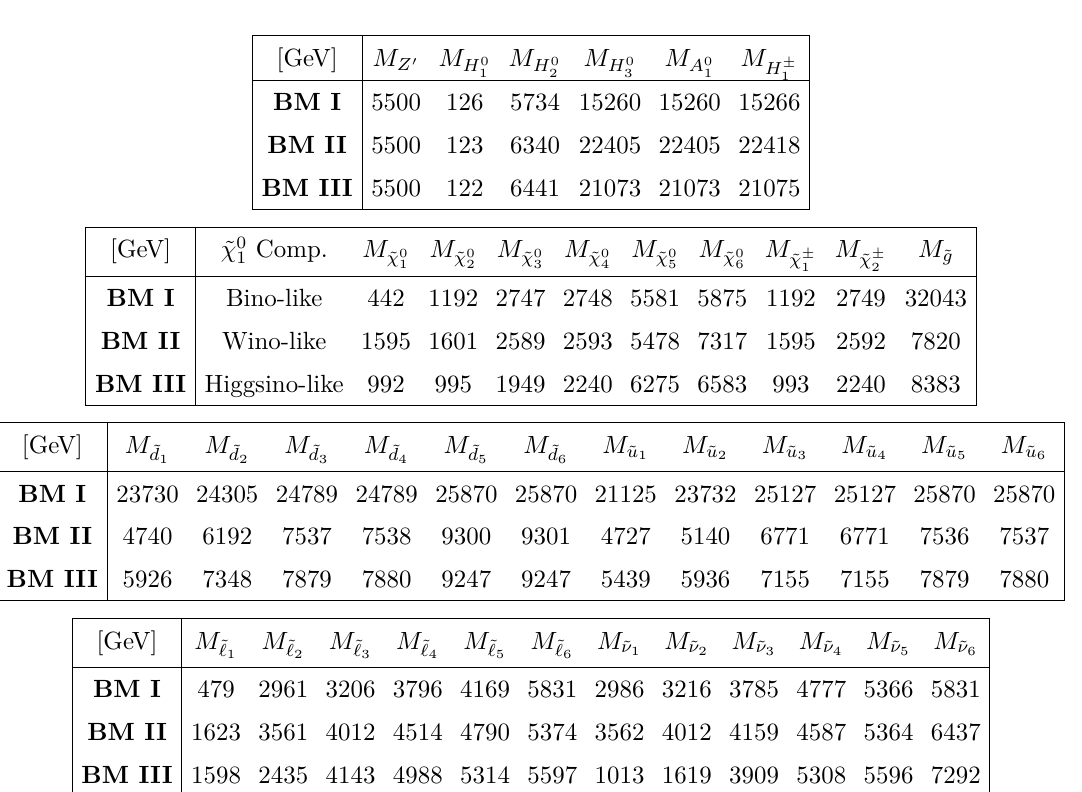
Table 6 . Particle spectrum of BM I , BM II and BM III : bosons (top), fermions (middle), squarks and sleptons (bottom). All masses are given in GeV.